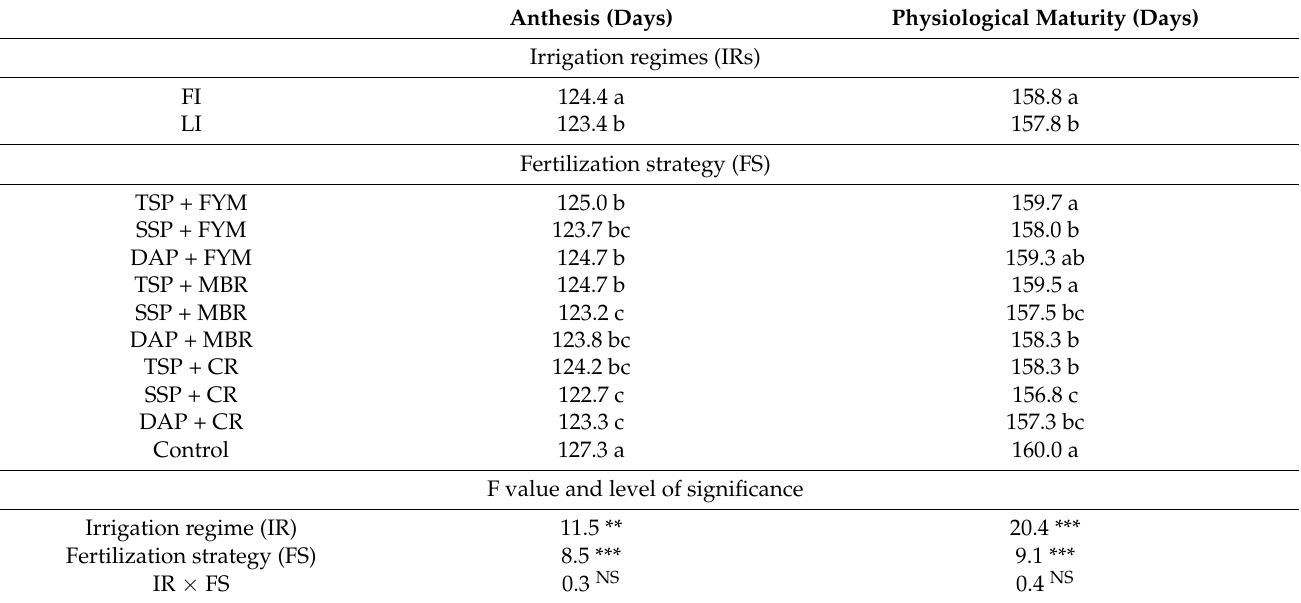
Table 2. The effect of fertilization sources and irrigation regimes on the days to anthesis and days to physiological maturity of